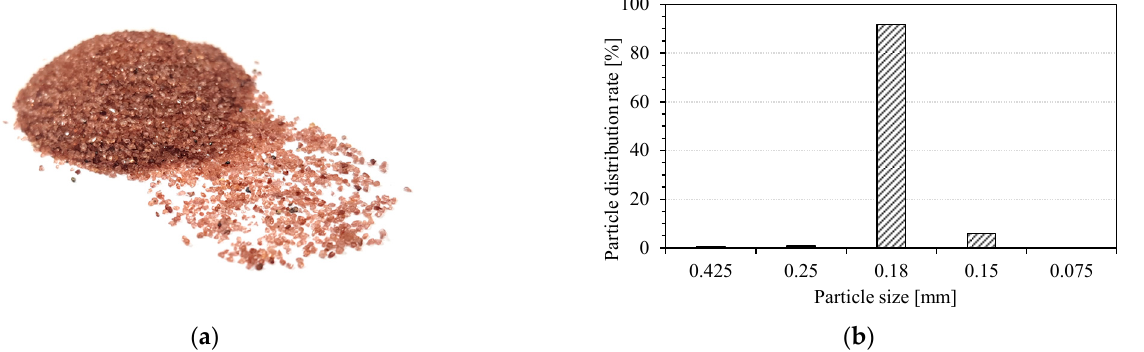
Figure 4. Experimental setup for abrasive waterjet rock cutting with pump and abrasive waterjet system.